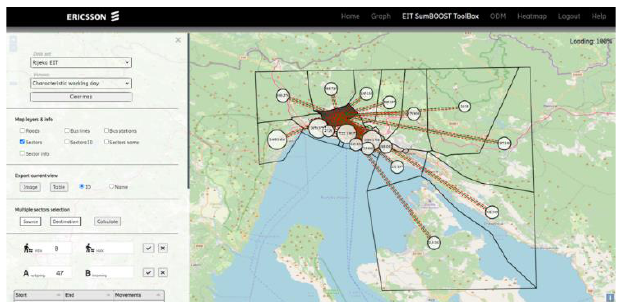
Figure 4. Example of toolbox graphical user